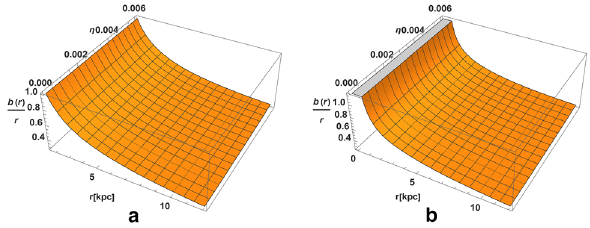
Fig. 10 The function b ( r ) with respect to r ( kpc ) and η is plotted by r using ρ 0 = 0.05 kpc − 2 , r 0 = 1 kpc with 0 ≤ η ≤ 0 . 006 for a NFW profile: r th = 1 . 7 kpc , b URC profile: r th = 1 kpc